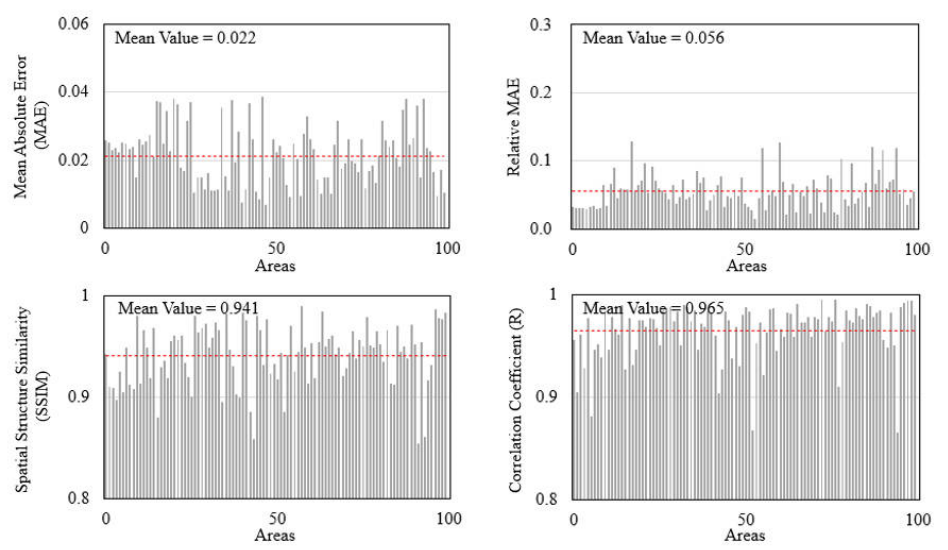
Figure 5. The quantitative assessments in 100 randomly selected subregions. One original Landsat image from July to September in each subregion was excluded from the reconstruction process and used as a reference image. The red dashed lines in each panel represent the values averaged over the 100 subregions.